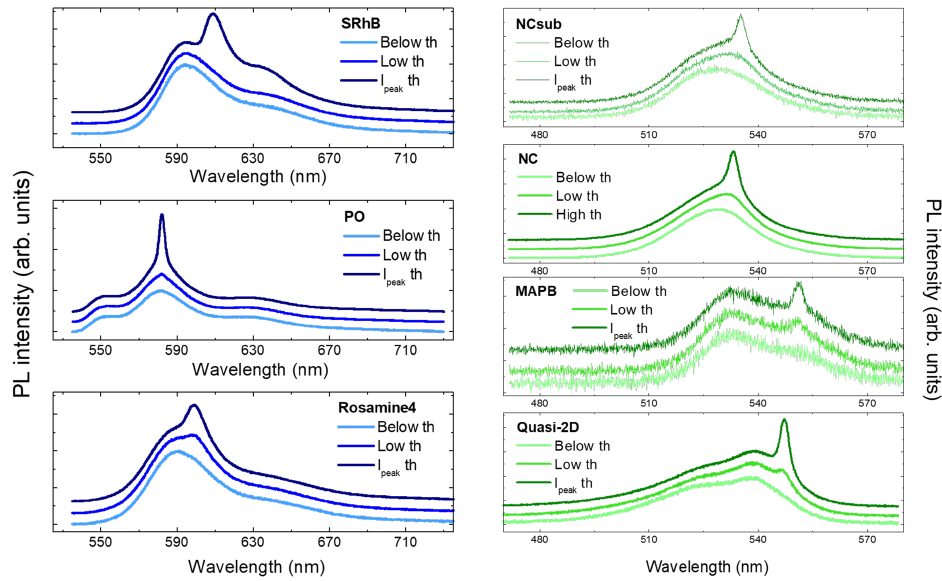
Figure 5. Comparison of PL spectra corresponding to different ASE thresholds. In particular, the belowth spectrum corresponds to PL acquired at low excitation density, below threshold; the lowth plot corresponds to a pump value closest to the minimum ASE threshold found for each sample; finally, the I peak th curve is the PL plot recorded at the excitation density closest to the I peak ASE threshold (the excitation density of the Lowth and I peak th spectra are typically between 0.95 and 1.05 times the corresponding threshold). PL spectra have been vertically stacked for the sake of